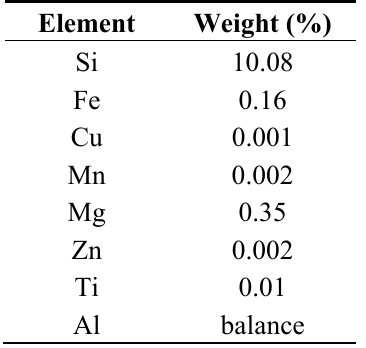
Table 2. Chemical composition of aluminum alloy powder as determined by inductively coupled plasma (ICP)